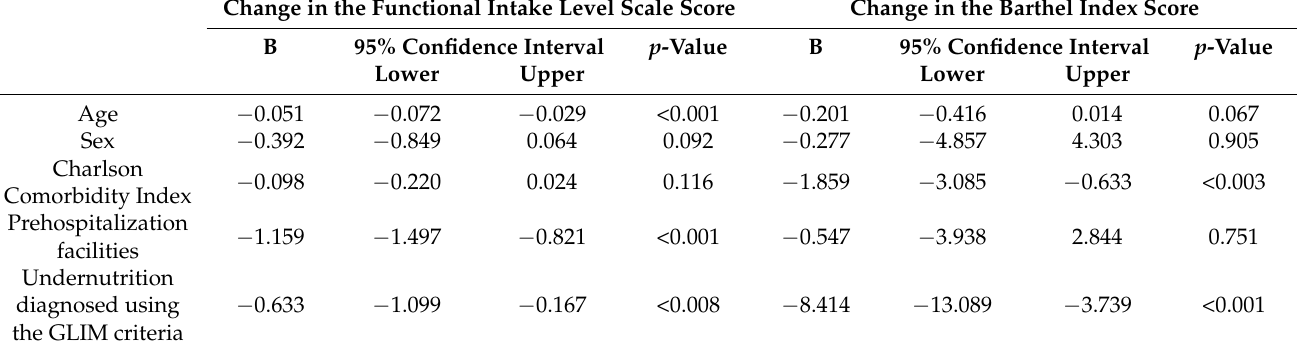
Table 4. Multiple regression analysis of changes in the Functional Intake Level Scale score and Barthel Index